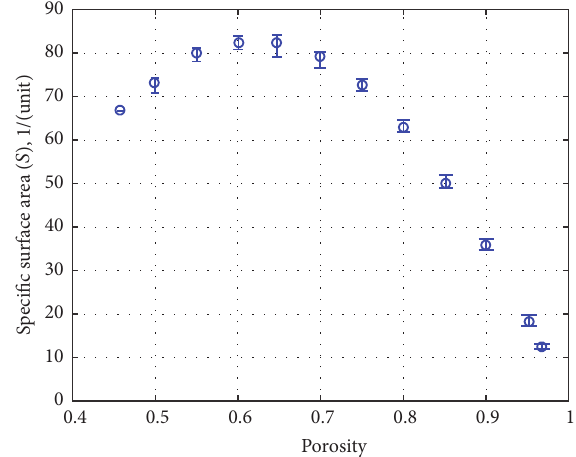
Figure 19: Specific surface area for randomly distributed squares, over the range of porosities studied. Specific surface area increases linearly as porosity decreases; however this trend deviates at lower porosities due to the large nonuniform shapes introduced into the lower porosity